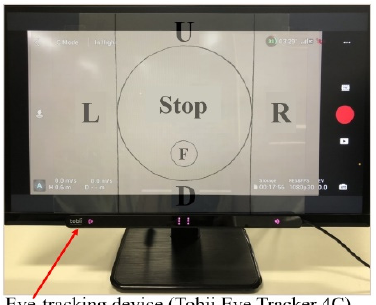
Figure 6. Experiment staff (Tokai University).